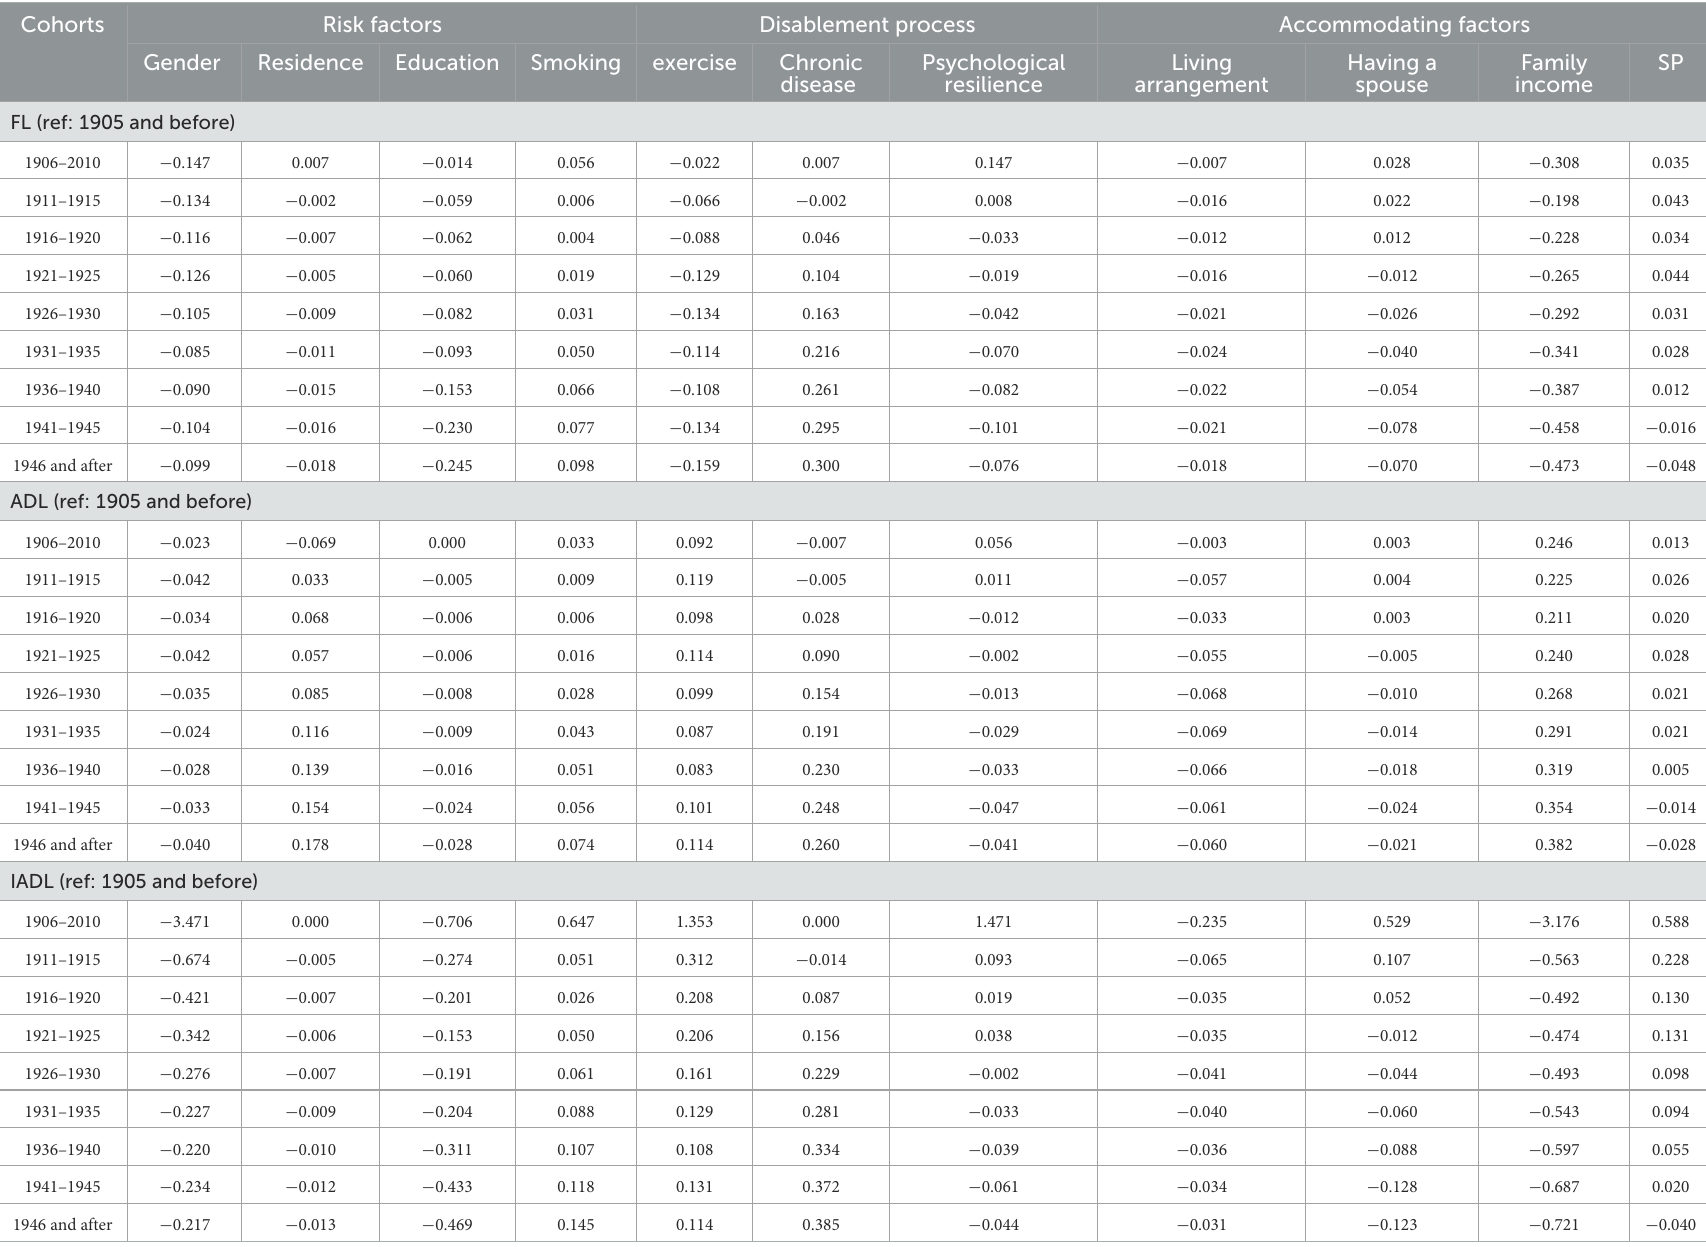
TABLE 2 The contributions of disablement process factors to ADL, IADL, and FL disabilities